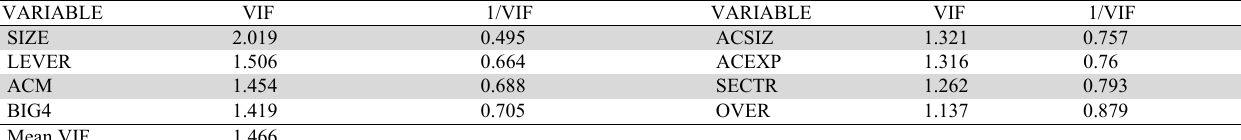
Standard Tests on VIF